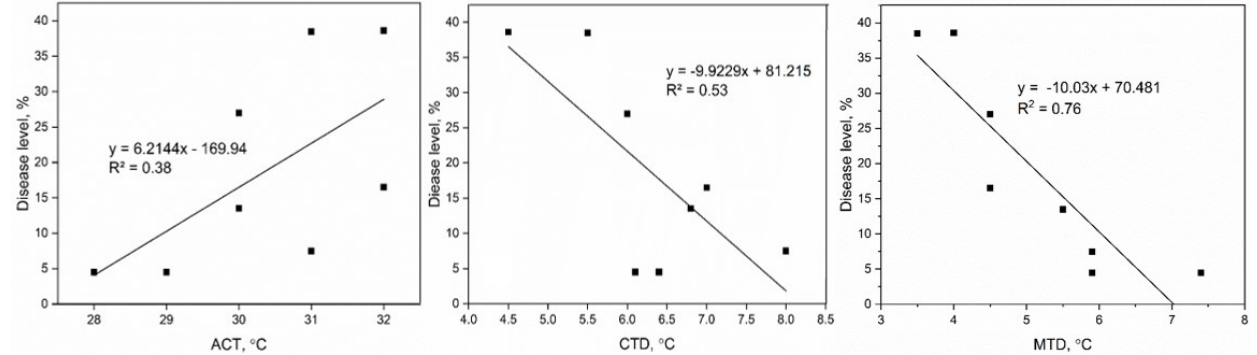
Figure 8. Regression analyses between disease level and average canopy temperature (ACT), canopy temperature difference (CTD), and maximum temperature difference (MTD).